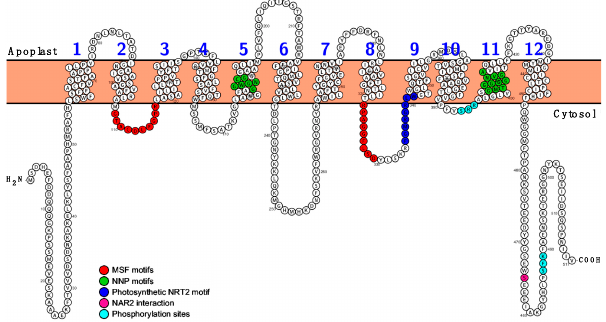
Figure 1. Predicted transmembrane topology for ZosmaNRT2 protein sequence. The 2D model was obtained by using the PROTTER program and TMHMM 2.0 for hydropathy. Conserved amino acids corresponding to each signature motif are colored as indicated: Mayor Facilitator Superfamily motifs (MFS I and II) in red, Nitrate Nitrite Porter motifs (NNP I and II) in green, and blue for the Photosynthetic NRT2 motif. S/T-x-R/K motifs, found in the majority of vascular plant, are colored in light blue, including Ser-393 and Ser-487, the phosphorylation sites. Ser-475, highlighted in dark pink, could be involved in NAR2 interaction (discussed in the text).